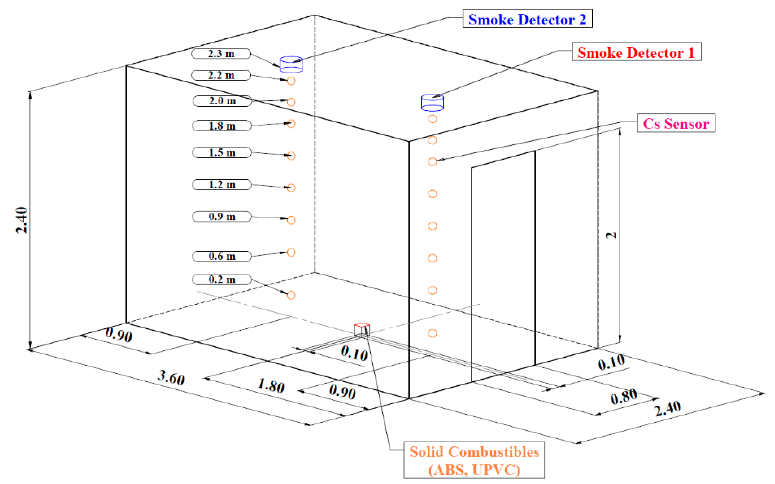
Figure 7. Schematics of ISO 9705 compartment and pre-selected locations of smoke detectors.